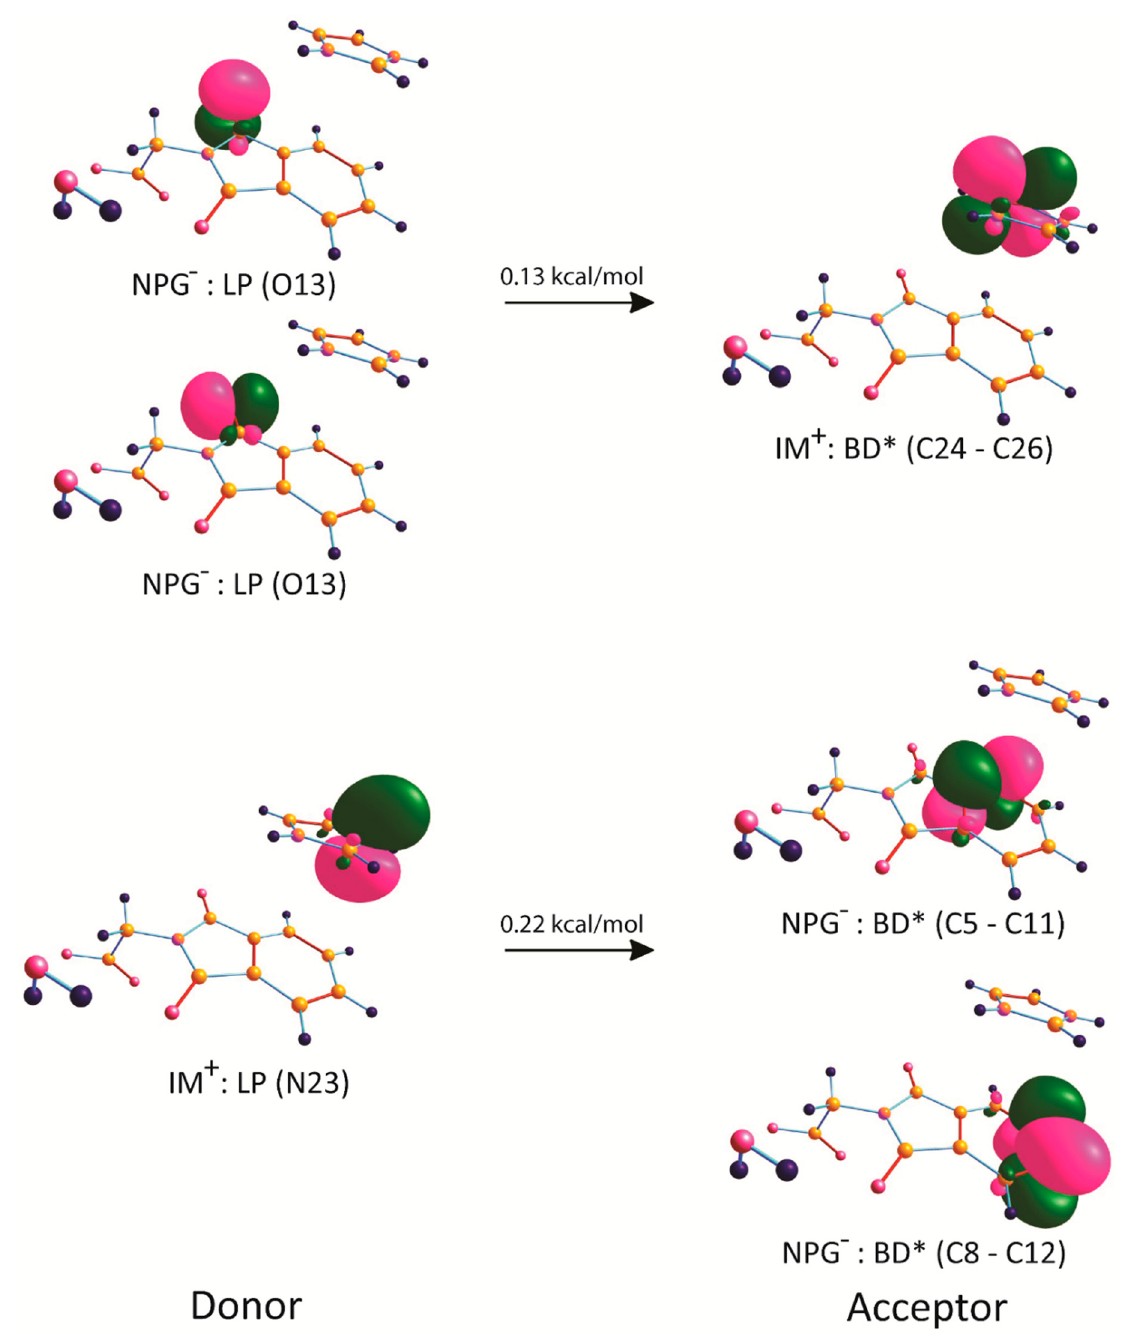
Figure 11. LP → BD* donor-acceptor orbitals’ interaction derived from the NBO analysis of IM + –NPG − –HYD (for configuration A ). Hydrogen atoms are omitted for clarity (isovalue = 0.03).